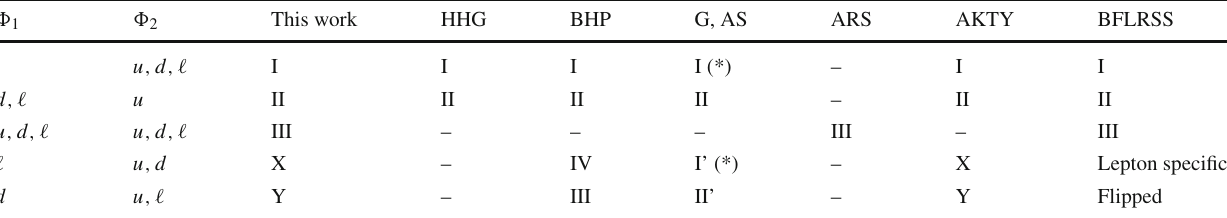
Atwood, Reina, Soni [297]. “AKTY”: Aoki, Kanemura, Tsumura, Yagyu [298]. “BFLRSS”: Branco, Ferreira, Lavoura, Rebelo, Sher, Silva